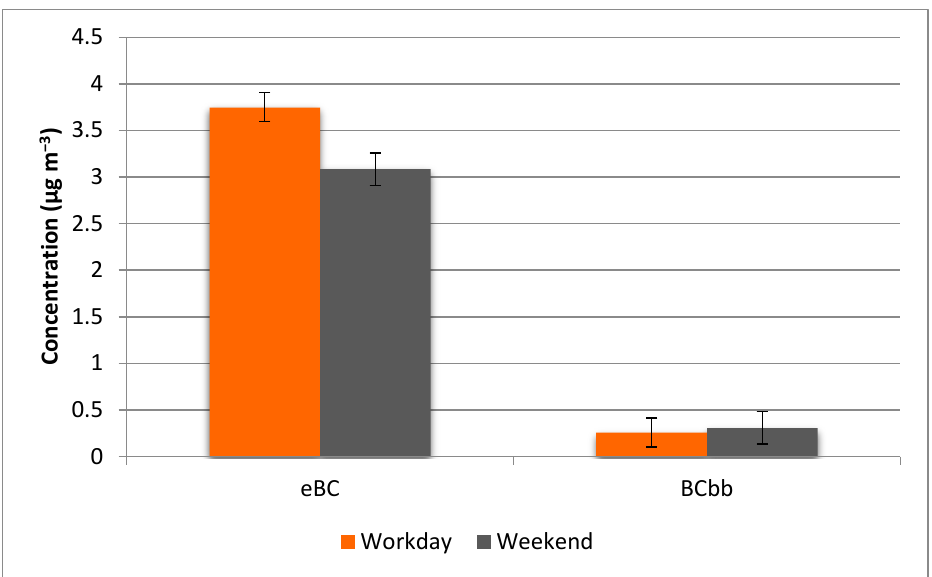
Figure 7. Mean concentrations of eBC and BC bb for weekend and workdays.